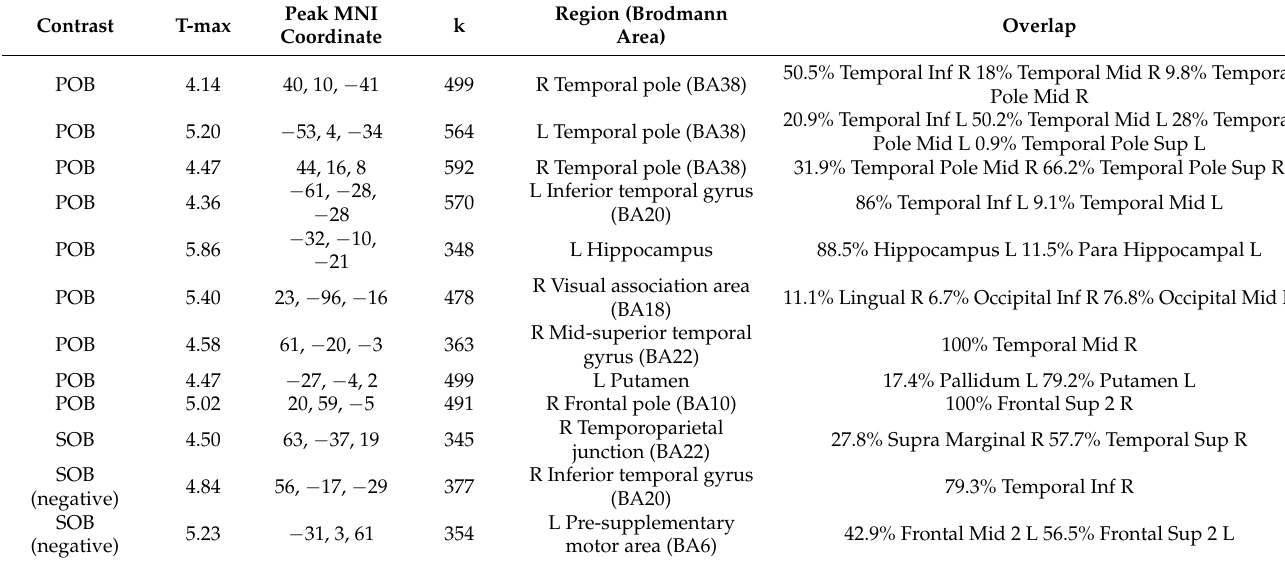
Table 1. VBM results for personal and social optimism